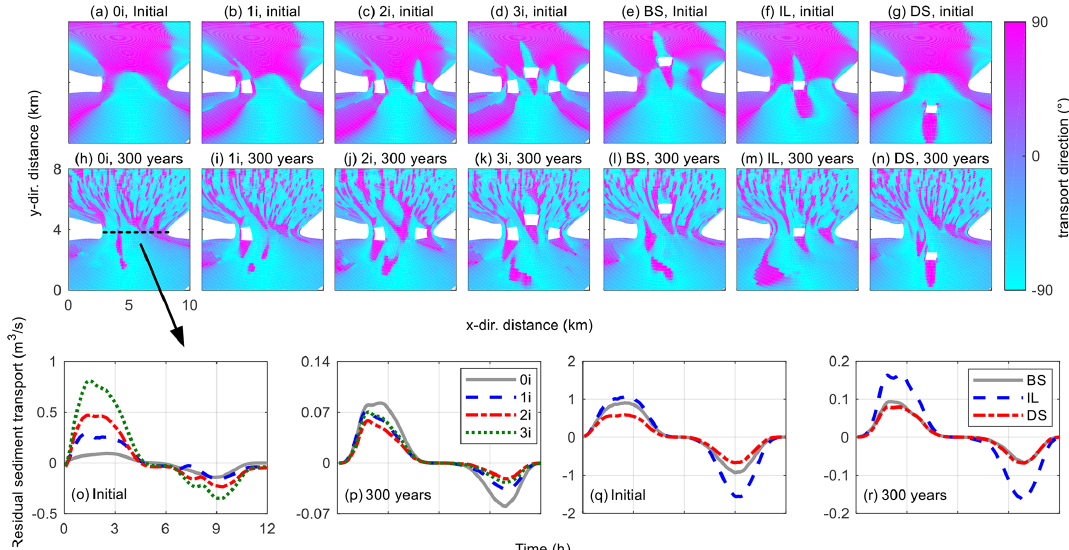
Figure 8. Residual sediment transport near the tidal inlet for different numbers of mouth islands (a–d, h–k) and different locations (e–g, l–n) at the beginning and after 300 years, respectively. The white area in the plot represents the mouth islands, and the background colour represents the direction of residual sediment transport (90 ◦ indicates landward transport while − 90 ◦ indicates seaward transport). Tidal residual sediment transport via a cross section of different scenarios at 0 (o, q) and 300 years (p, r) , respectively. In panels (o) – (r) , a positive value indicates seaward transport, while a negative value indicates landward transport.